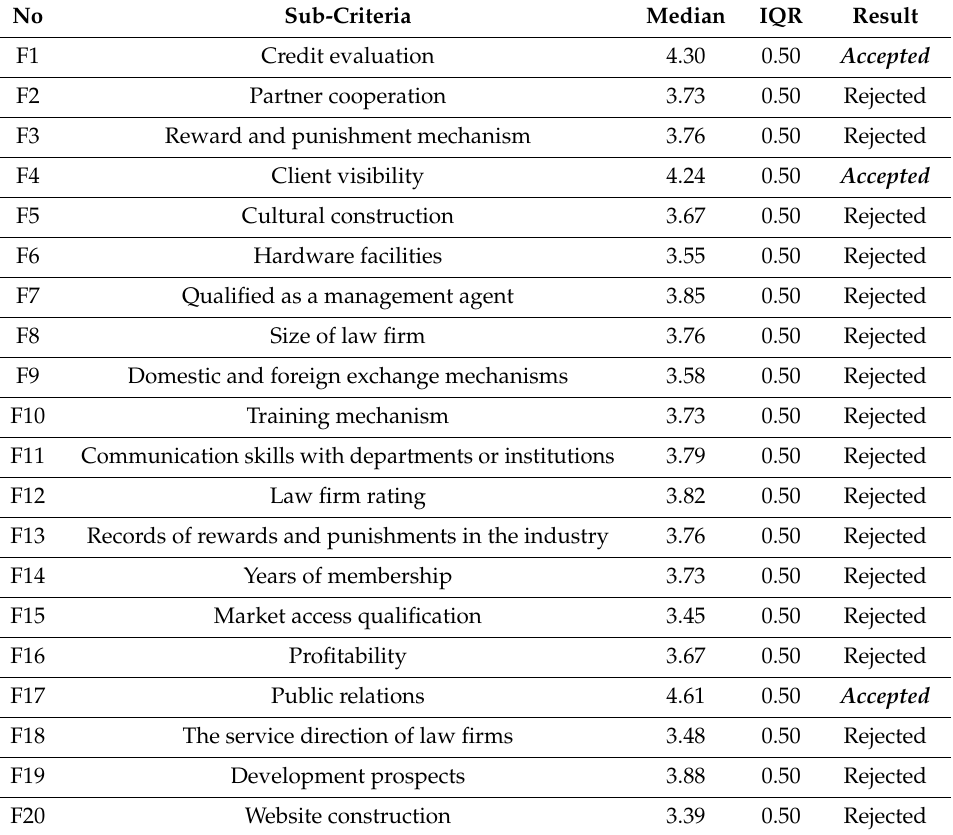
Table 5. Verified results of the practice experience.